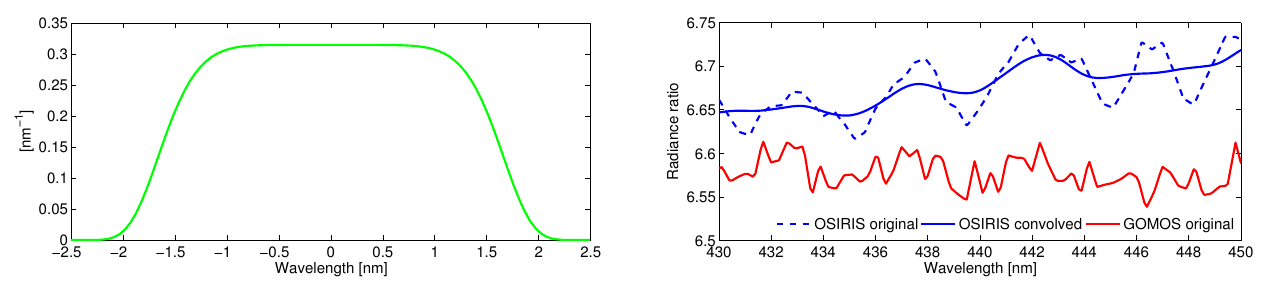
Fig. 3. GOMOS slit function. Fig. 4. Comparison of GOMOS and OSIRIS spectral resolution in the NO 2 retrieval region. Shown are 32km radiances normalized with the 47km spectra. The GOMOS ratio is before stray light correction and scaled to fit in the figure.